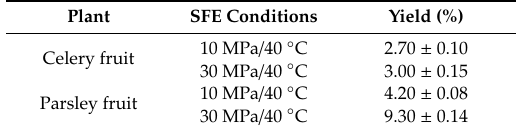
Table 1. Yields obtained in the SFE from celery and parsley fruits.